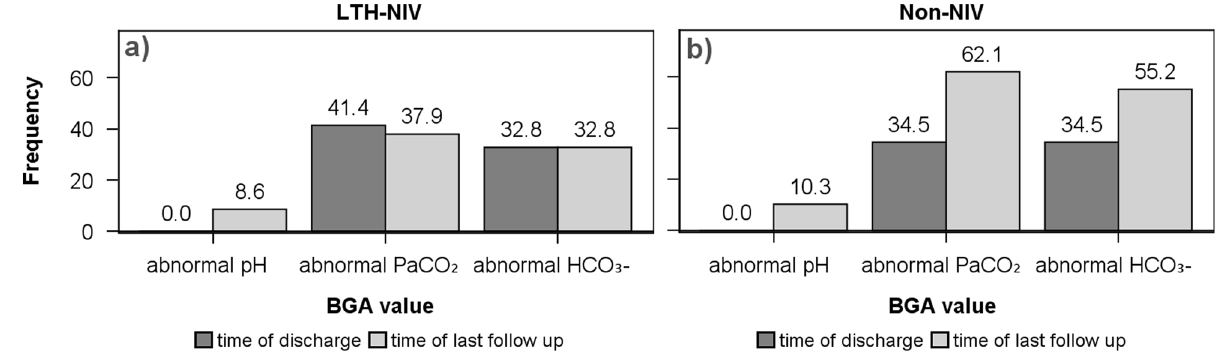
Figure 2. Comparison of selected BGA-values between LTH-NIV patients ( a ) and Non-NIV patients ( b